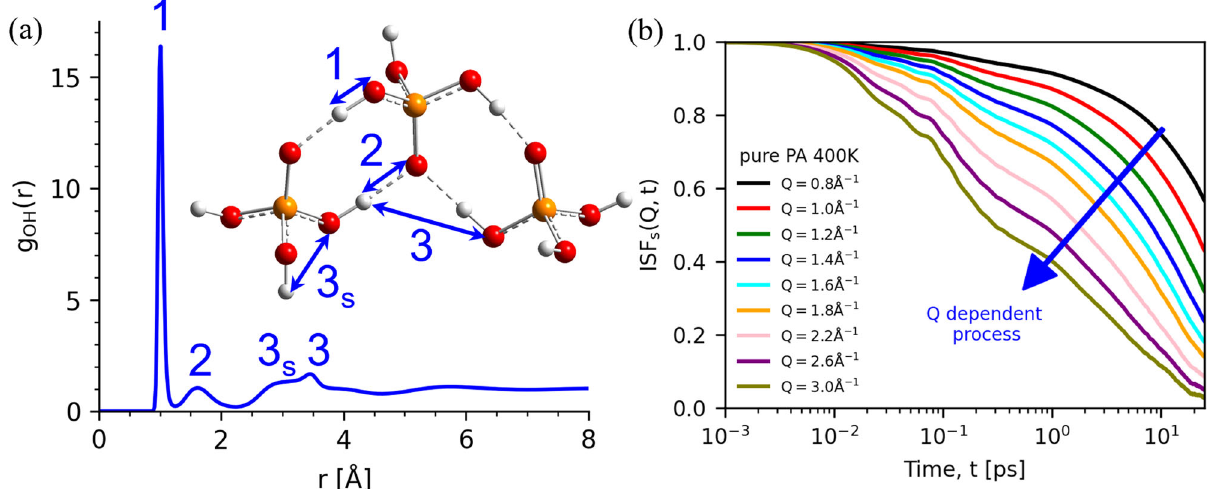
Fig. 7 The radial distribution function and self-intermediate scattering function. a The radial distribution function ( g OH ) of oxygen-hydrogen in PA obtained from AIMD. The shoulder on the left side of the 3 rd peak marked 3 s corresponds to the distance between the proton and the oxygen atoms in the same PA molecule. b Self-intermediate scattering function ISF(Q , t) of protons with different Q values at 400 K for pure